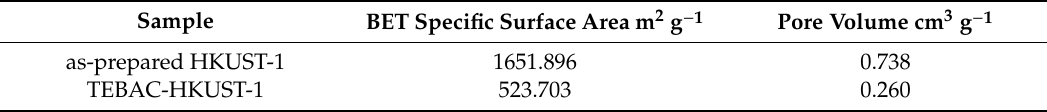
Figure 5. Nitrogen adsorption-desorption isotherm and corresponding NLDFT pore-size distribution curve of HKUST-1 ( a 1 , a 2 ) and TEBAC-HKUST-1 ( b 1 , b 2 ). Table 1. The surface area and total pore volume of samples.